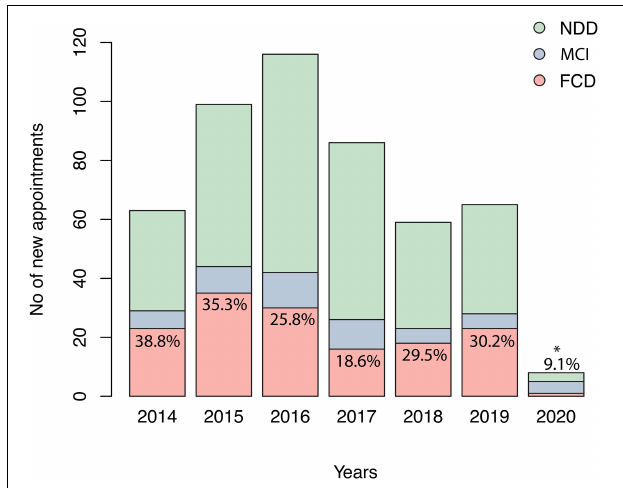
FIGURE 2 | Number of new appointments in the memory clinic studied. Relative percentages represent the number of diagnoses of FCD divided by total new appointments of the corresponding year. FCD, functional cognitive disorder; MCI, mild cognitive impairment; NDD, neurodegenerative disorders. *Decrease in total number of appointments related to Coronavirus disease pandemic.